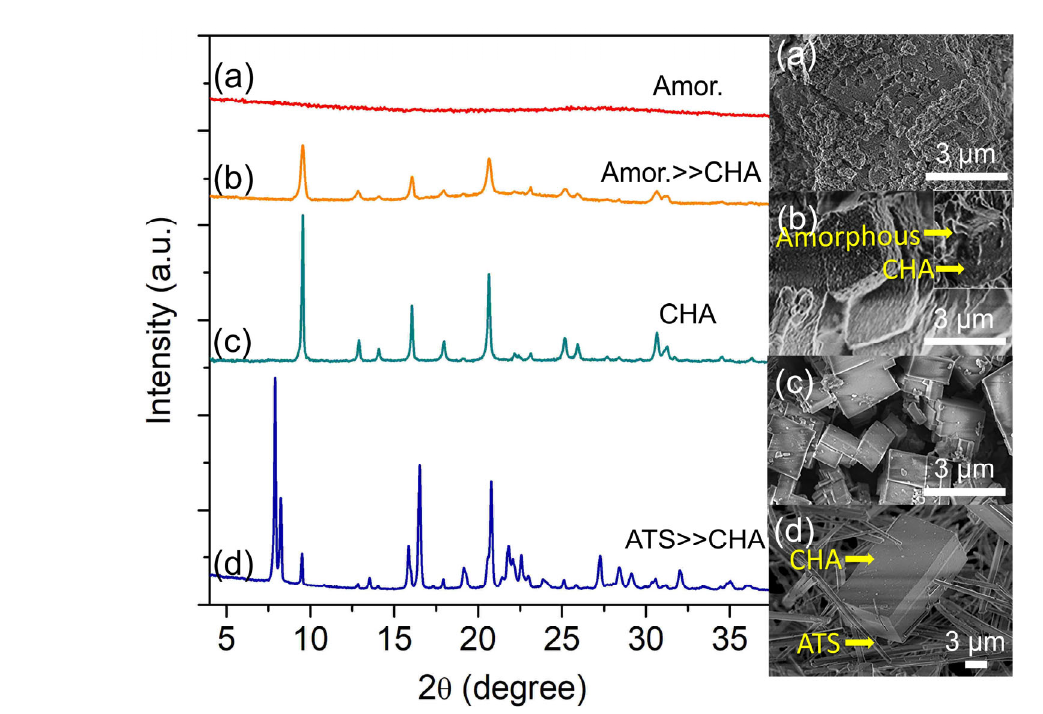
Figure 1. XRD patterns and FESEM micrographs of ( a ) S ‐ 1, ( b ) S ‐ 2, ( c ) S ‐ 3, and ( d ) S ‐ 4 solids heated at 150 °C for 12 h, 16 h, 19 h, and 30 h,